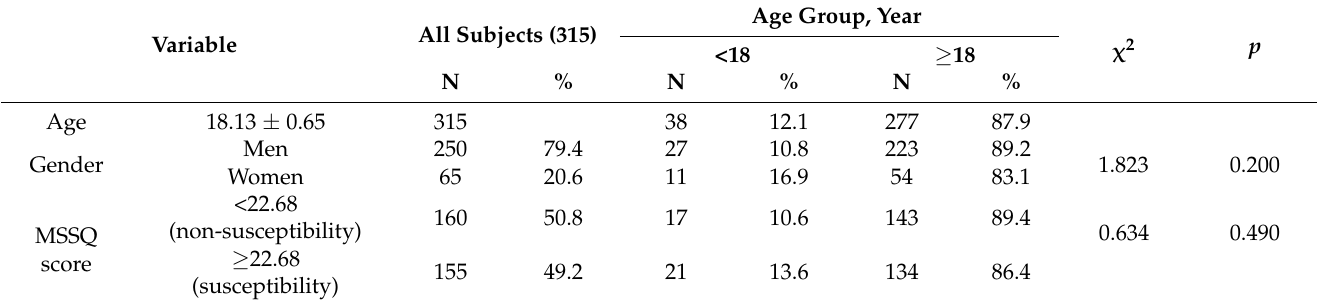
Table 1. General characteristics of the subjects in the first part: demographics and percentages of the variables (N = 315).